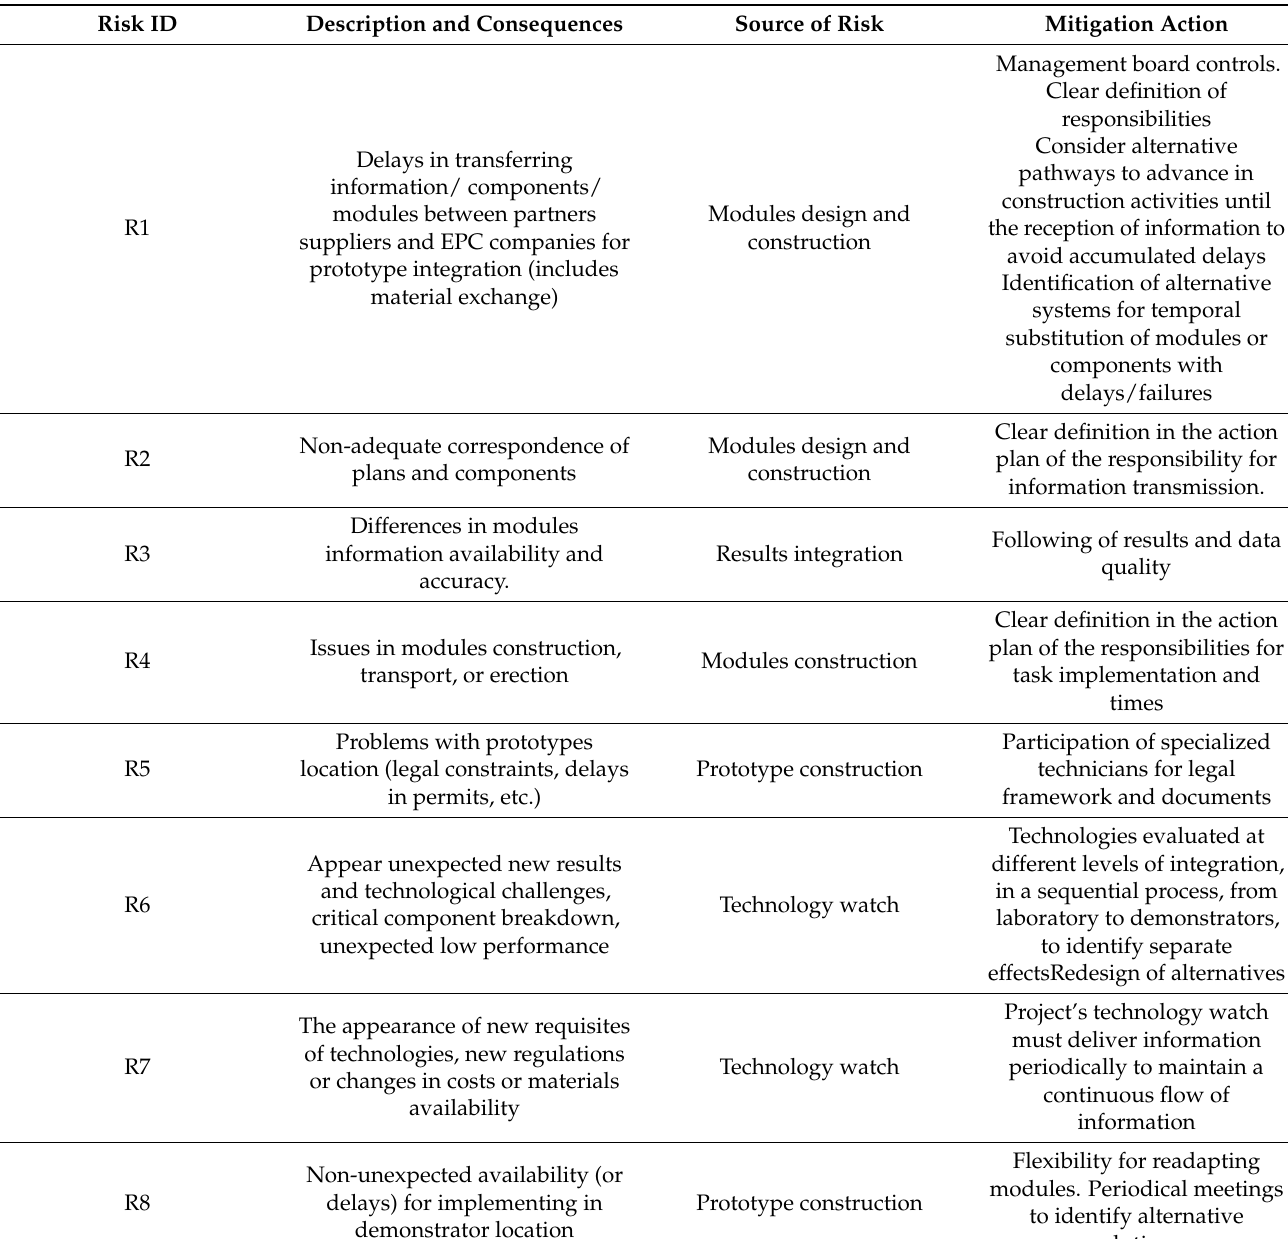
Table 1. Definition of main risks affecting the construction of the